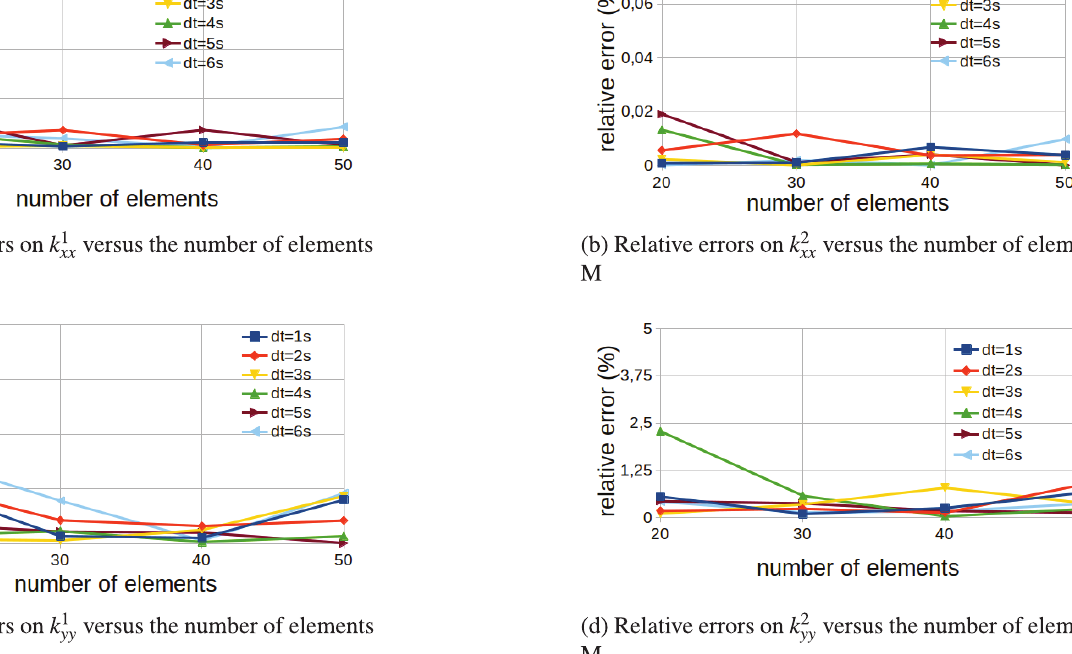
Fig. 2. Relative errors on the conductivity tensor without noise on the temperature fields for a PA material for several number of elements (M) along X and Y directions.